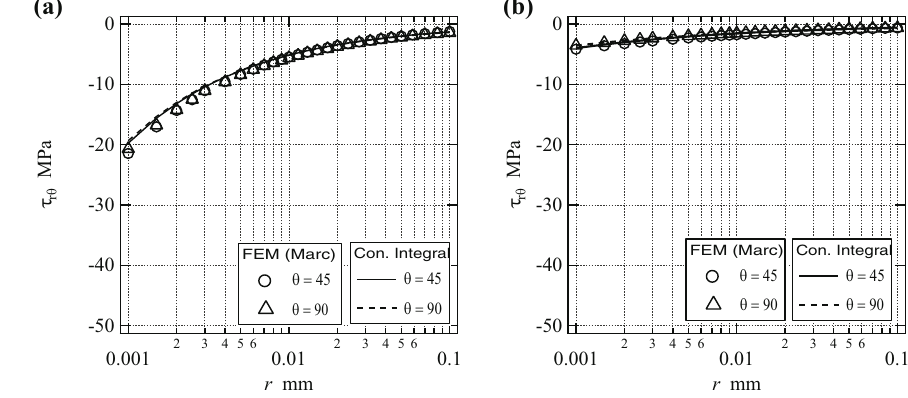
Figure 6: Distribution of shear stresses, τ rθ , at ϕ = 45° and θ = 45° and 90° with respect to r : ( a ) Vertex - 1 and ( b ) Vertex -